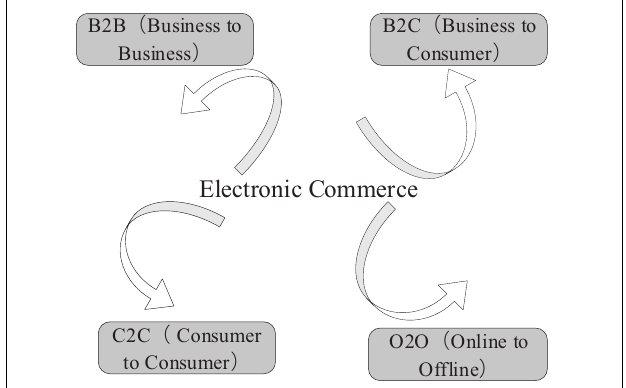
FIGURE 2 | Main e-commerce